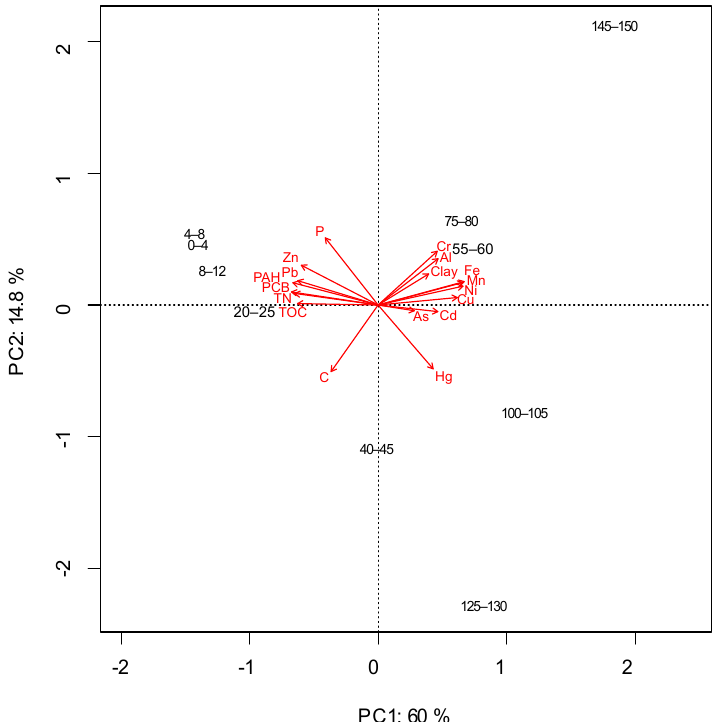
Figure 4. Principal component analysis (PCA) plot of geochemical data.